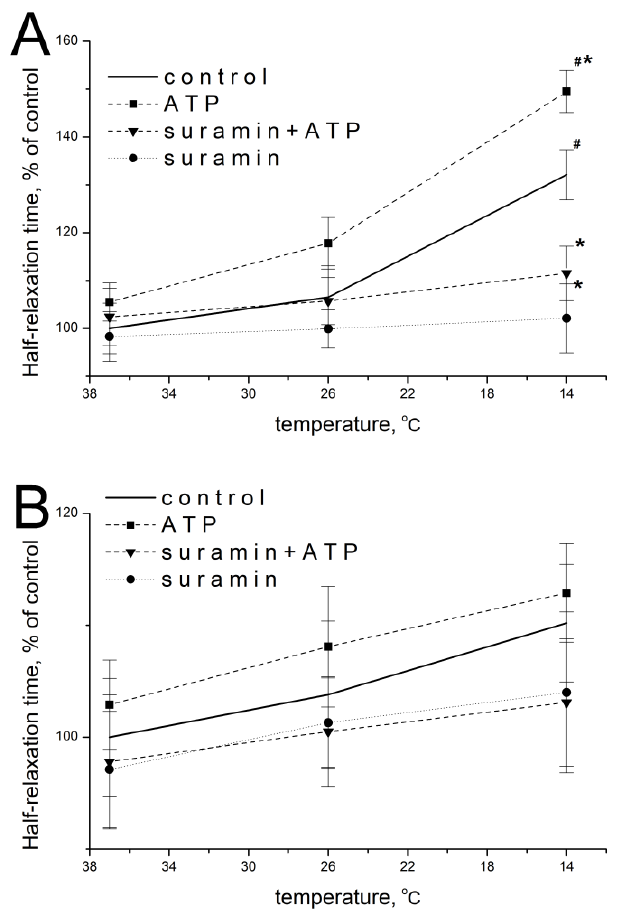
Figure 3. Effects of ATP (100 µ M) and suramin (100 µ M) on the half-relaxation time of electrical- stimulation-induced contraction of m. soleus ( A ) and m. EDL ( B ) at an elevated Ca 2+ concentration (7.2 mM) under different temperature regimes. n = 8–14. # p < 0.05 from the effect at 37 ◦ C, * p < 0.05 from